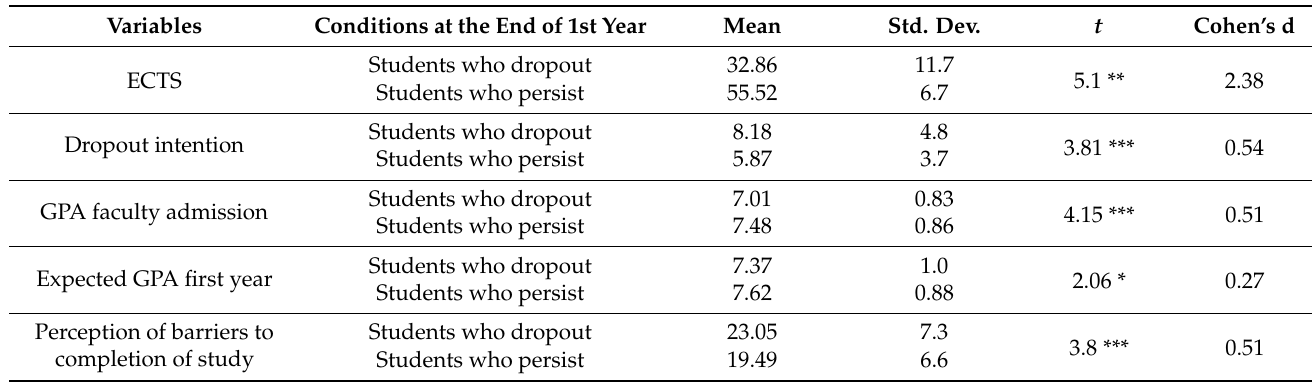
Table 4. Differences between the students in real dropout and the students that persist at the end of the first year